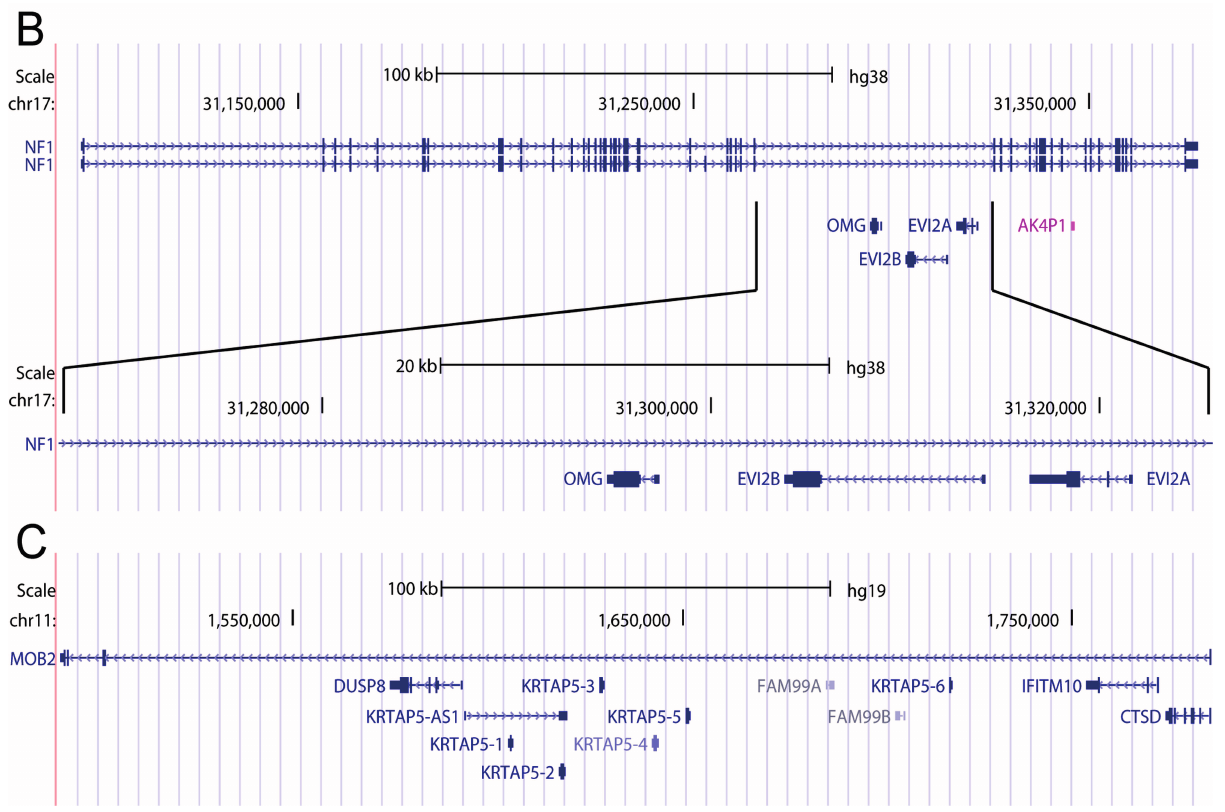
Figure 2. Selected tracks for the human MTOR ( A ); NF1 ( B ) and MOB2 ( C ) genes. ( A